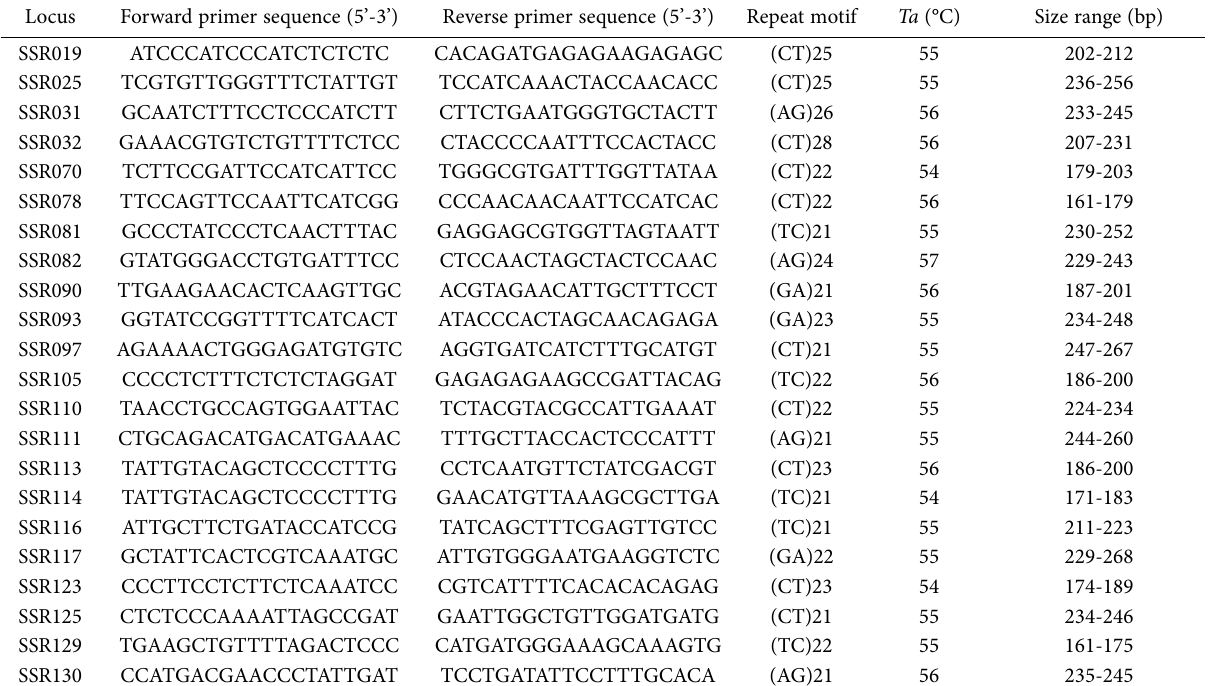
Table 2 Characteristics of SSR primers used in this research. Shown for each primer pair are forward and reverse primer sequences, repeat motif, annealing temperature (Ta), and the size range of alleles fragment